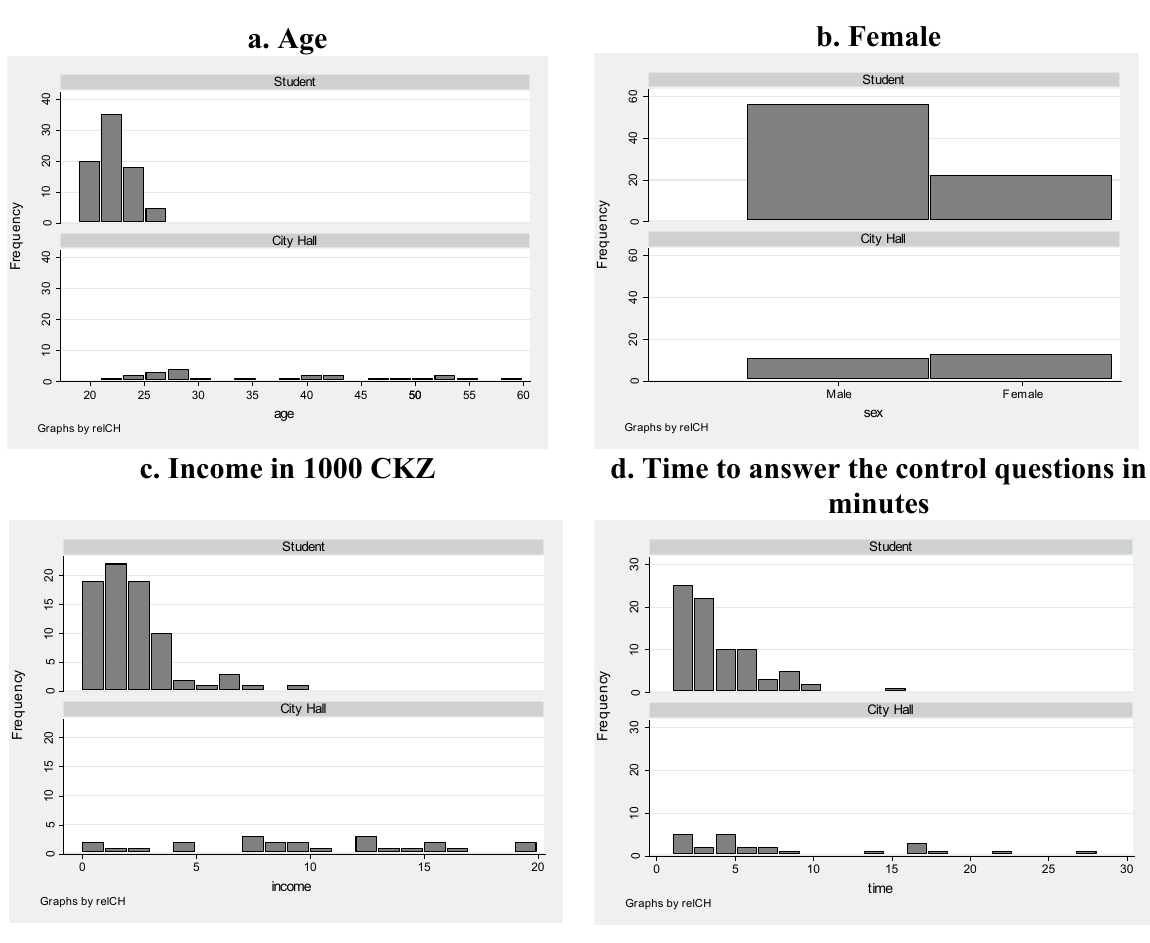
Figure A.1. Socio-demographic characteristics of City Hall employees and